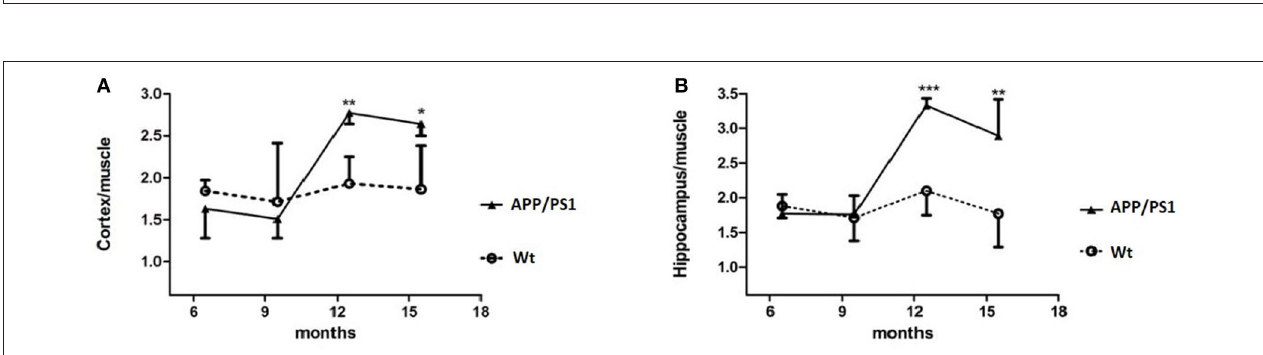
FIGURE 5 | The PET images were aligned with the mouse brain MRI template atlas. We selected the hippocampus and cortex as the VOIs and calculated their percentages of injected dose per gram (%ID/g). PET/MRI template atlas fusion images and graphs representing [ 18 F]DPA714 signals in APP/PS1 vs. Wt mice 12–13 and 15–16 months of age. Black and gray arrows point to cortex and hippocampus, respectively ( ∗ p < 0.05, ∗∗ p < 0.01, ∗∗∗ p < 0.001).